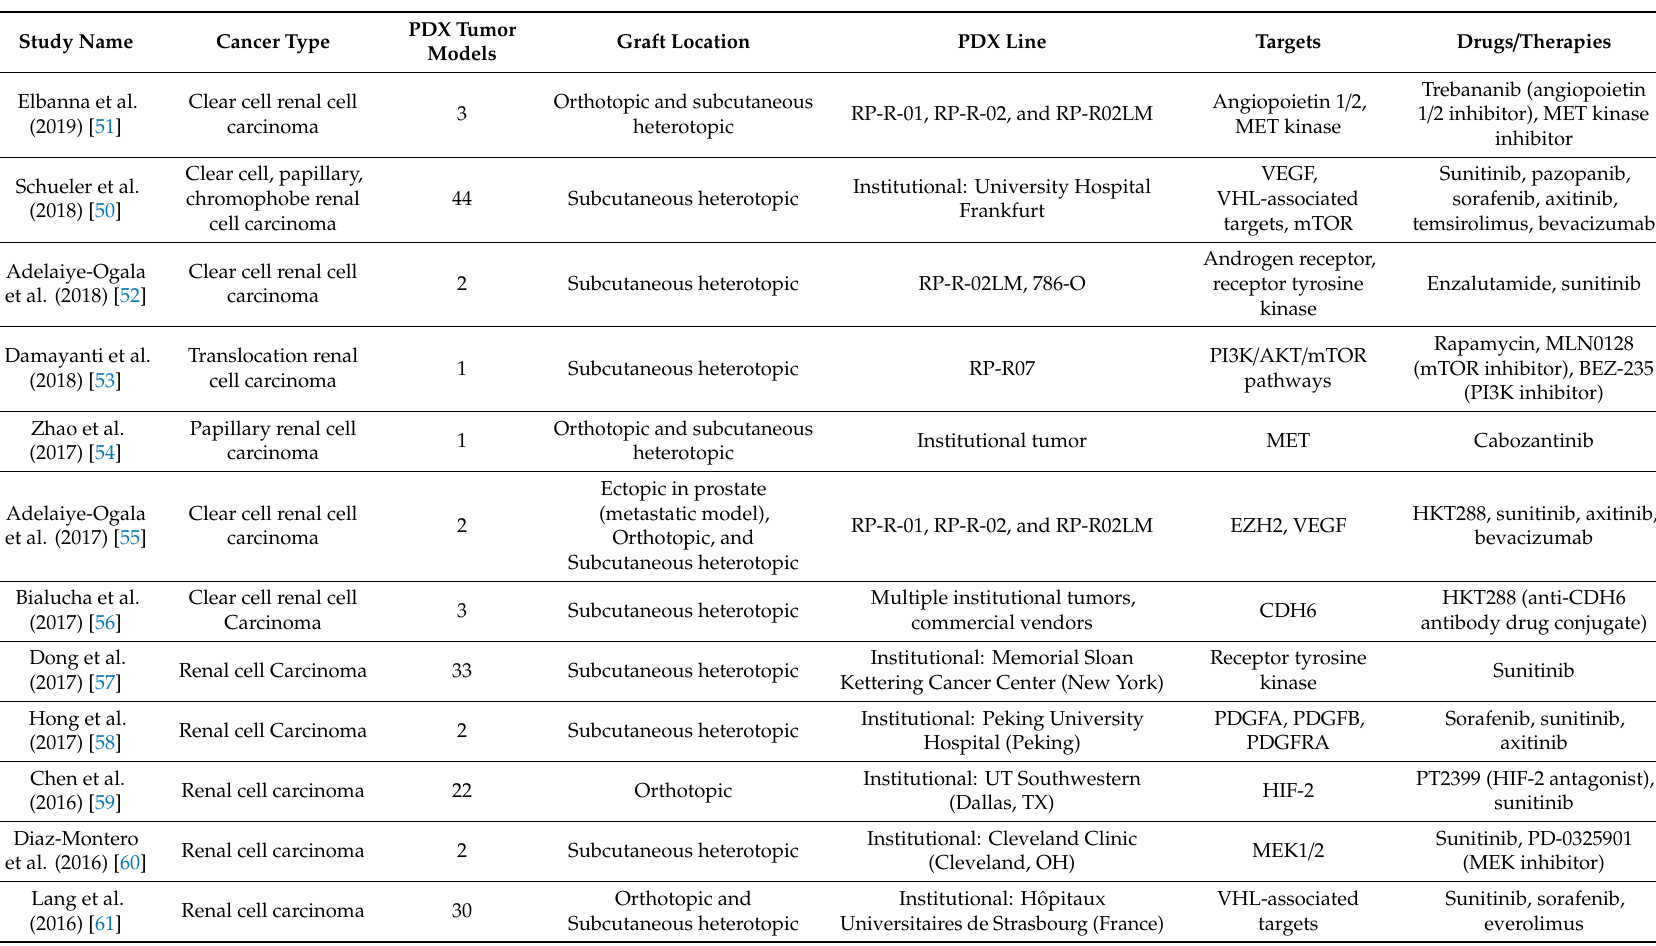
Table 1. Published studies of targeted anti-neoplastic treatments utilizing novel patient-derived tumor xenografts models in renal cell